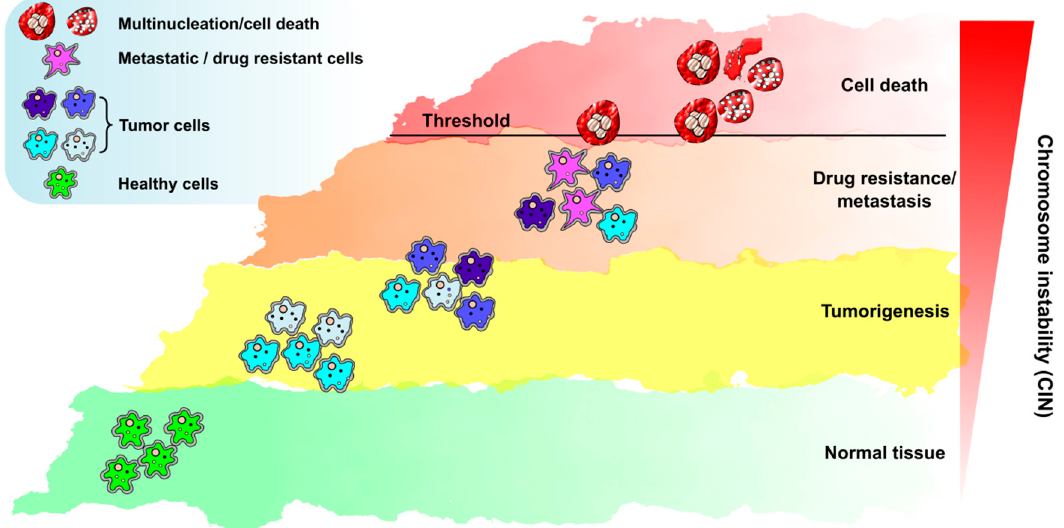
Figure 3. The multifaceted role of CIN in carcinogenesis. Normal tissue (bottom, green shade) can become tumorigenic under circumstances directly or indirectly associated with the induction of replication stress (yellow shade). At that point, tumor cells commonly present a low level of chromosome instability (CIN), which can serve as a fuel for early steps of cellular transformation and thus enable the carcinogenic process (yellow shade). As the tumor progresses (orange shade), cells become increasingly genetically unstable. Under these conditions, CIN can promote the fast acquisition of multiple tumor characteristics such as drug resistance and metastasis. Eventually, if CIN levels are very high, cells can reach a threshold in which they are no longer viable (red shade). Surviving cells in these stages are highly genetically unstable, with an increased probability of being multinucleated after subsequent cycles of aberrant mitosis finalization. Such a scenario has good chances of triggering cell death due either to improper gene expression or to sub-optimal S and M phase finalization.